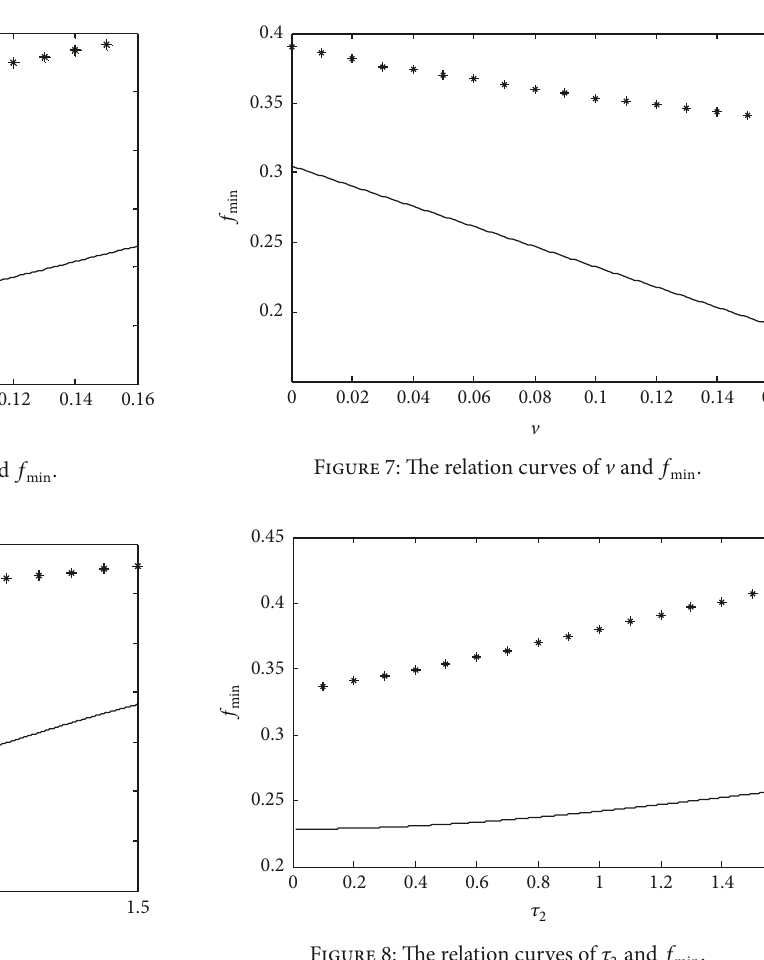
Figure 6: The relation curves of √𝑘𝜏 1 and 𝑓 min .